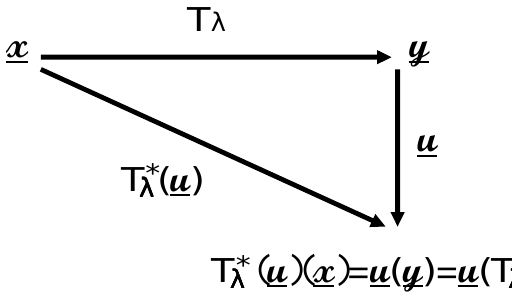
Fig. 2. Scheme of the “pullback” T ∗ from the coordinates y to x with the help of the (anisotropic) space contraction/dilation T λ